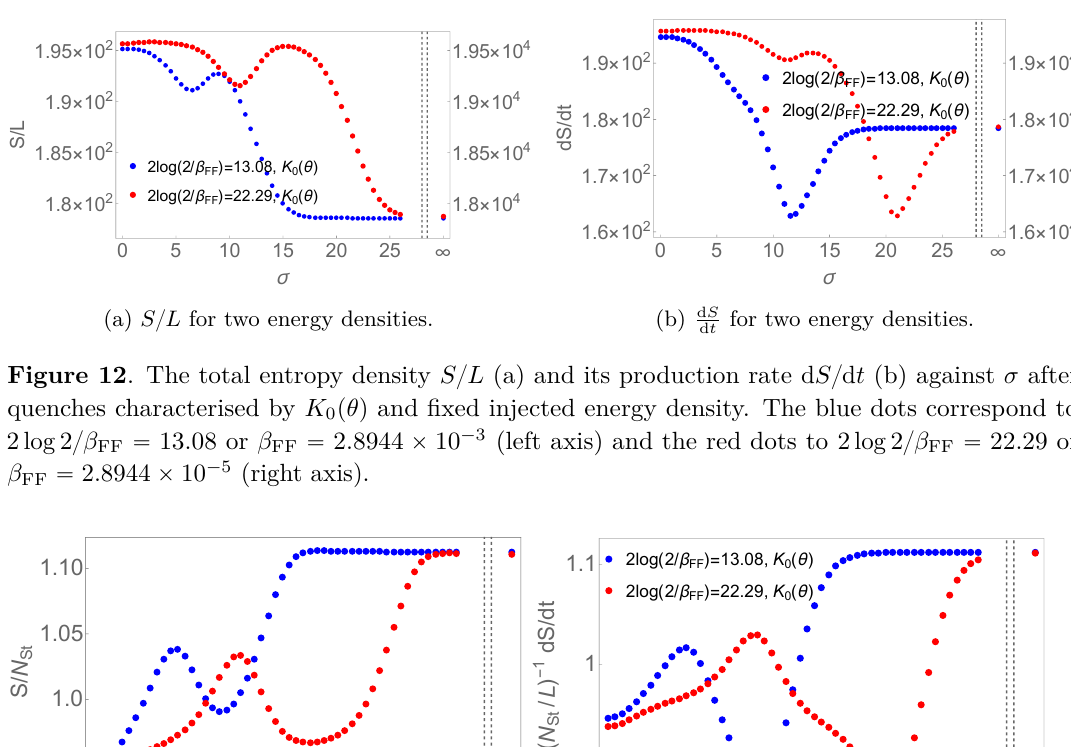
´ 1 ˆ d S { d t st { L q